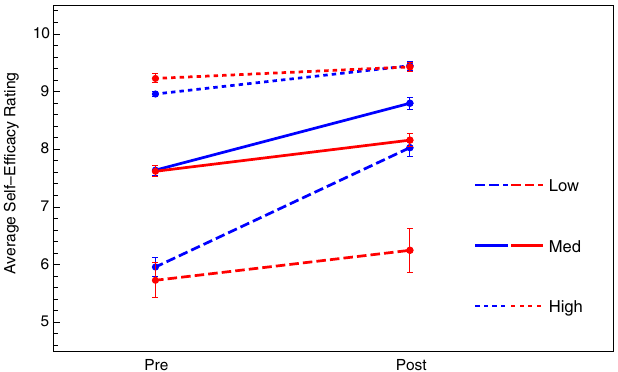
FIG. 7. Mean pre- and postsurvey self-efficacy ratings for students categorized as having low ( < 6 . 5 ), medium ( < 8 . 5 ), or high ( ≥ 8 . 5 ) initial self-efficacy for physics (blue lines) and math (red lines). These low, medium, and high rankings are shown by the dashed, solid, and dotted lines, respectively. Error bars represent one standard error of the